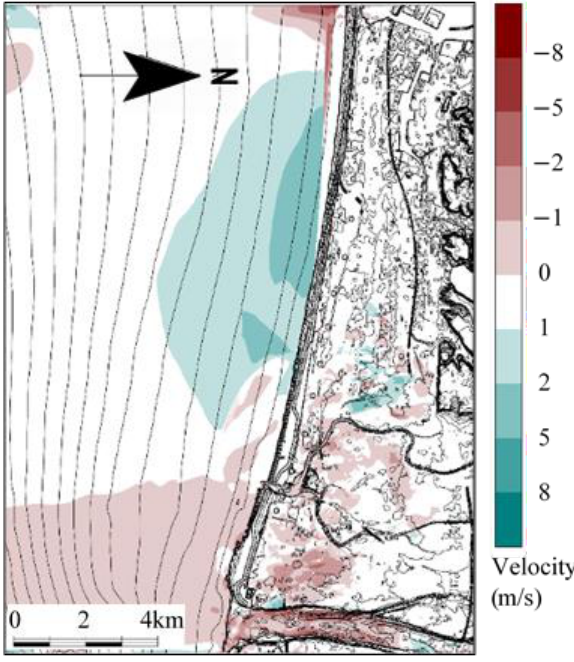
Figure 17. Tsunami velocity 33 min after the start of calculation (after structure developments).